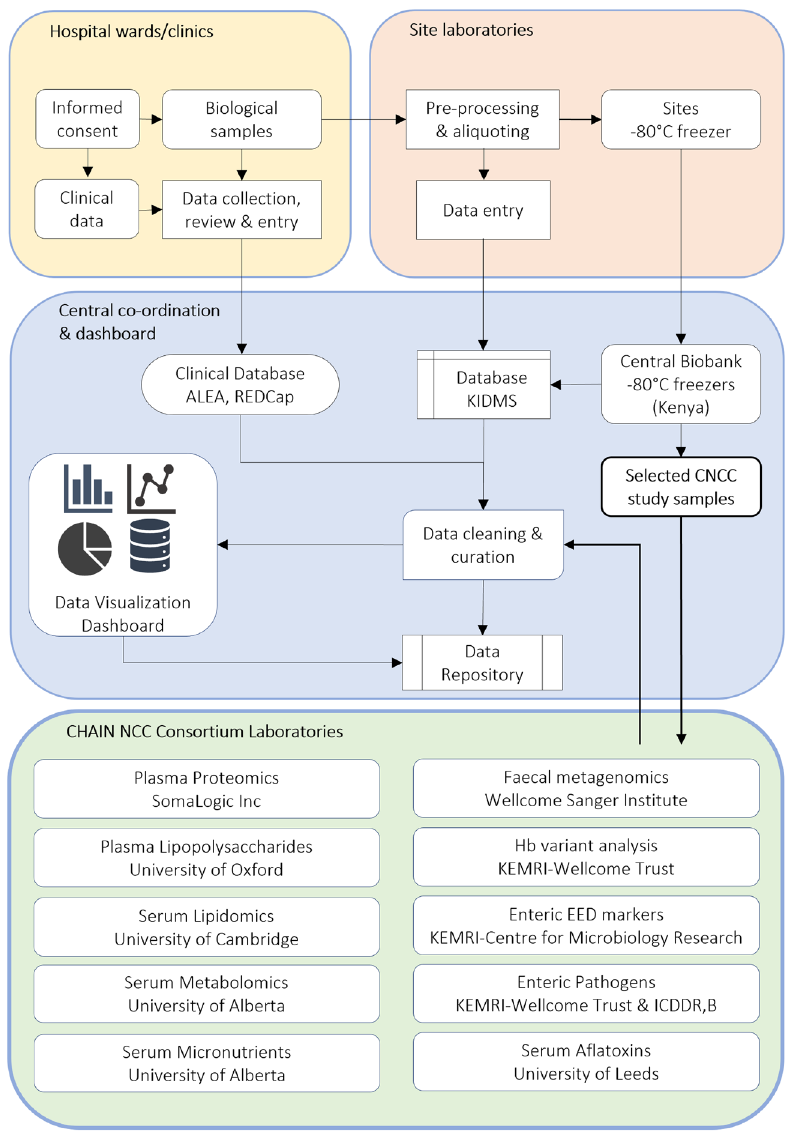
Figure 2. Samples collection, processing, storage and shipment workflow. Consent and sampling was carried out at the site’s ward or clinic. Samples were collected, pre-processed and stored at the study site -80 °C freezers. The duration from sampling to storage was ~44 minutes. Data curation and visualisation was done in R and the shiny application where queries and reports were transmitted online to sites for prompt and timed resolution. Data for samples was captured in the Kilifi Integrated Data Management System (KIDMS) that was linked to patient data in the clinical database captured on Research Electronic Data Capture (REDCap). Samples were subsequently shipped to the central biobank facility at KEMRI Wellcome Research Programme. CHAIN NCC study samples were analysed in the